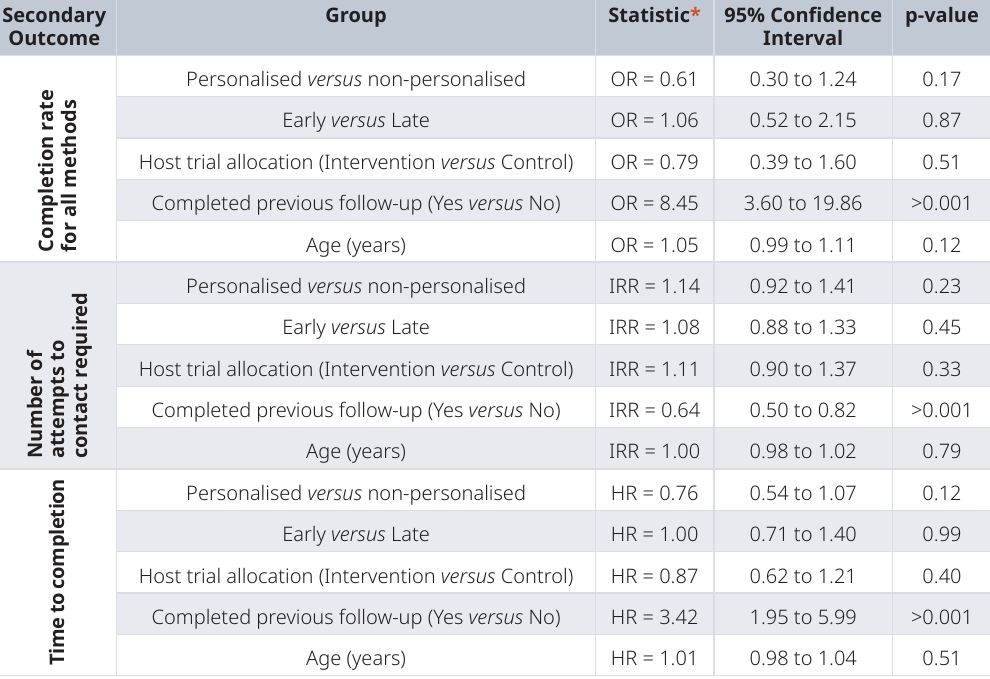
Table 4. Results for the secondary